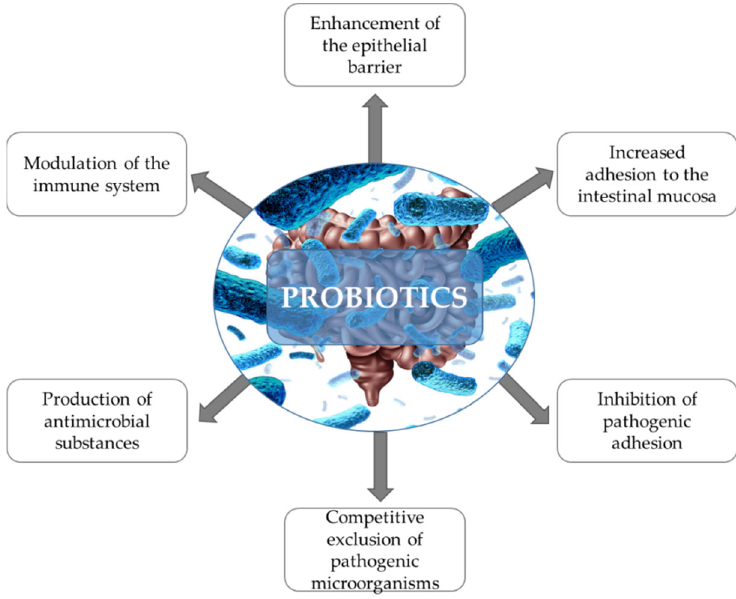
Figure 1. Major mechanisms of probiotic activity in the human body.